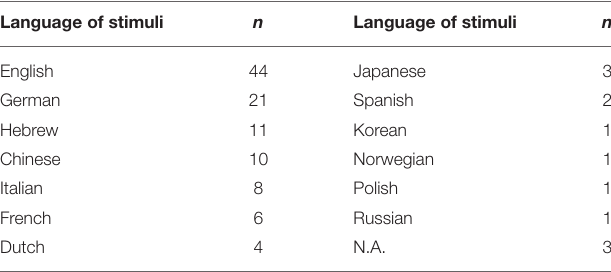
TABLE 3 | Languages of the stimuli used in the studies ( n = 116) in the review corpus. Language of stimuli